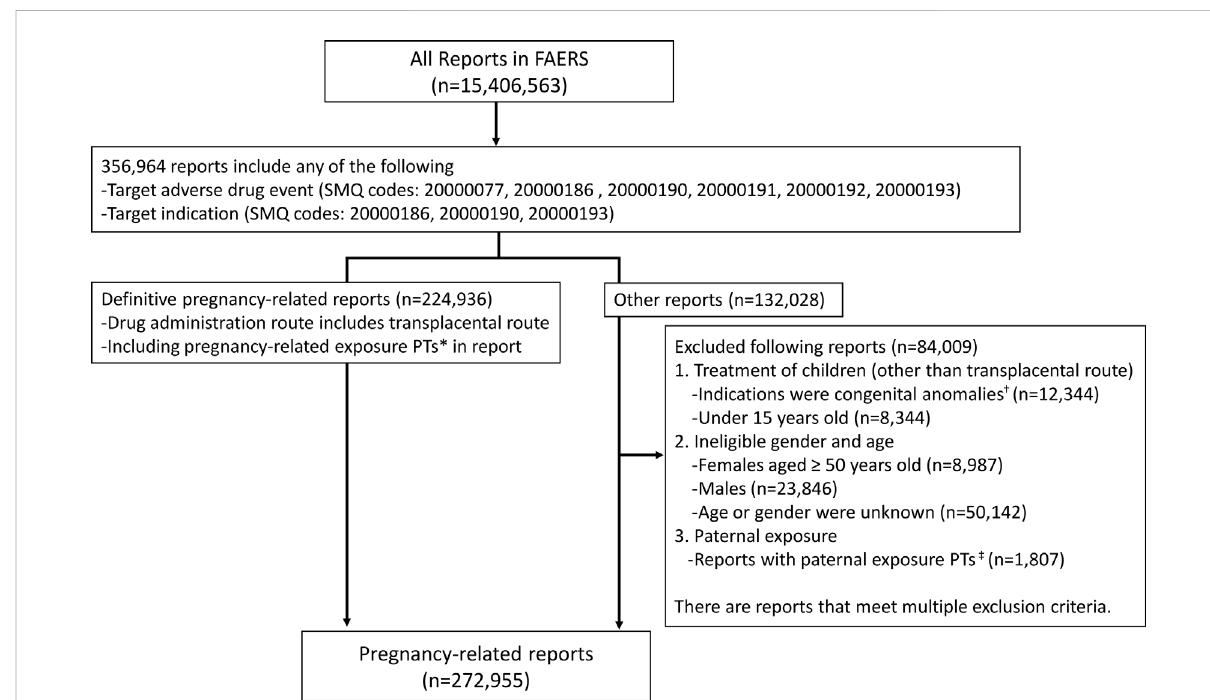
FIGURE 1 Dataextractionofpregnancy-relatedreportsfromtheFoodandDrugAdministrationAdverseEventReportingSystem.*PTs:maternalexposure during delivery (10071407), foetal exposure during delivery (10071409), maternal exposure before pregnancy (10071406), maternal exposure during pregnancy (10071408), fetal exposure during pregnancy (10071404), exposure during pregnancy (10073513), maternal exposure timing unspeci fi ed (10071415), foetal exposure timing unspeci fi ed (10071405), maternal drugs affecting foetus (10026923), drug exposure before pregnancy (10064998). † SMQs: congenital, familial, and genetic disorders (20000077). ‡ PTs: paternal drugs affecting the fetus (10050425), exposure via